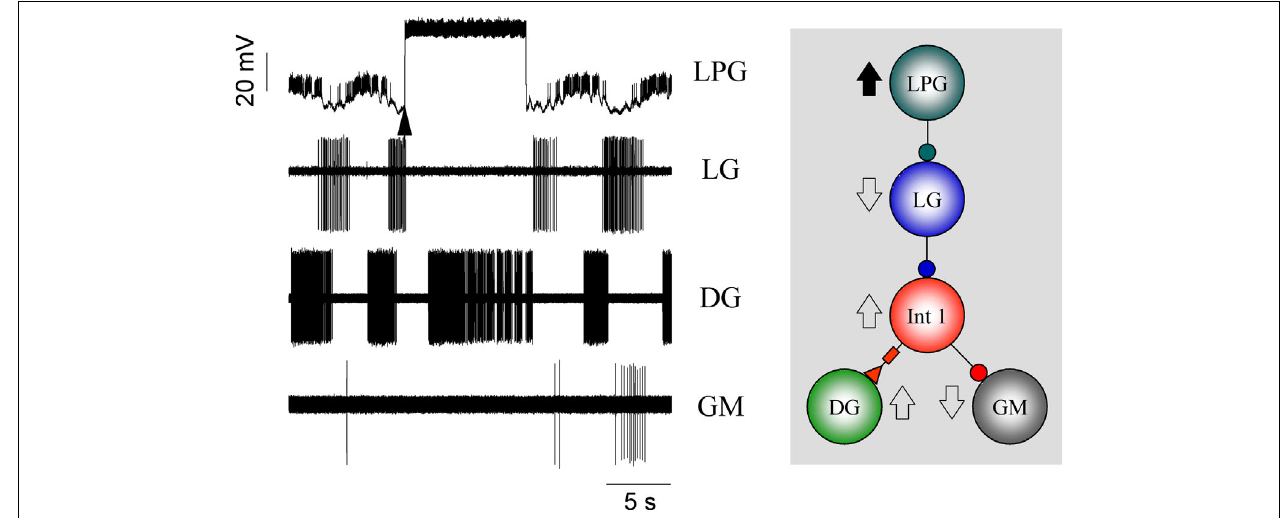
FIGURE 10 | Feedback from the LPGs to the LG forms a reciprocal inhibitory loop that also has effects on the rest of the network. Here a long depolarizing pulse into the LPG neuron terminates LG bursting